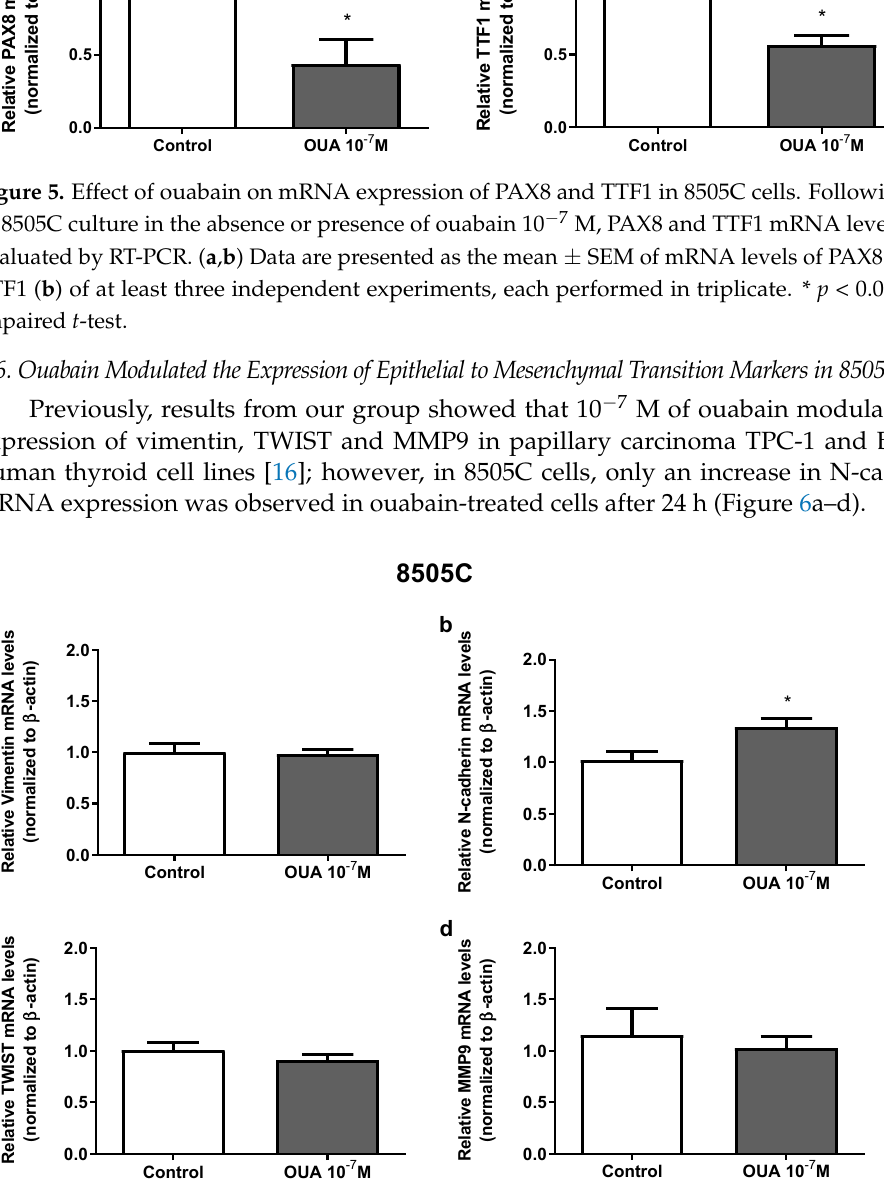
Figure 6. Effect of ouabain on aggressiveness markers expression in 8505C cells. Following 24 h of 8505C culture in the absence or presence of ouabain 10 − 7 M, aggressiveness markers expression was evaluated by RT-PCR. ( a – d ) Data are presented as the mean ± SEM of mRNA levels of Vimentin ( a ), N-cadherin ( b ), TWIST ( c ) and MMP9 ( d ) of at least three independent experiments, each performed in triplicate. * p < 0.05 using unpaired t-test.